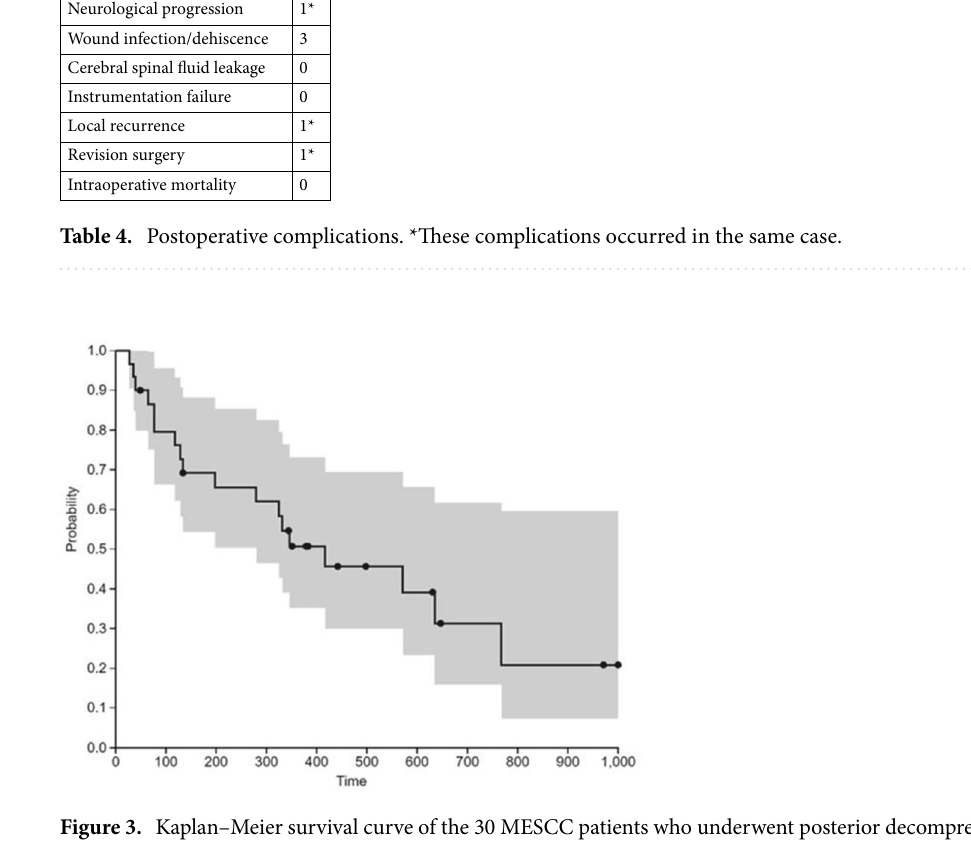
Figure 3. Kaplan–Meier survival curve of the 30 MESCC patients who underwent posterior decompression and stabilization without neither fusion nor anterior reconstruction surgery (black circle = censored observations